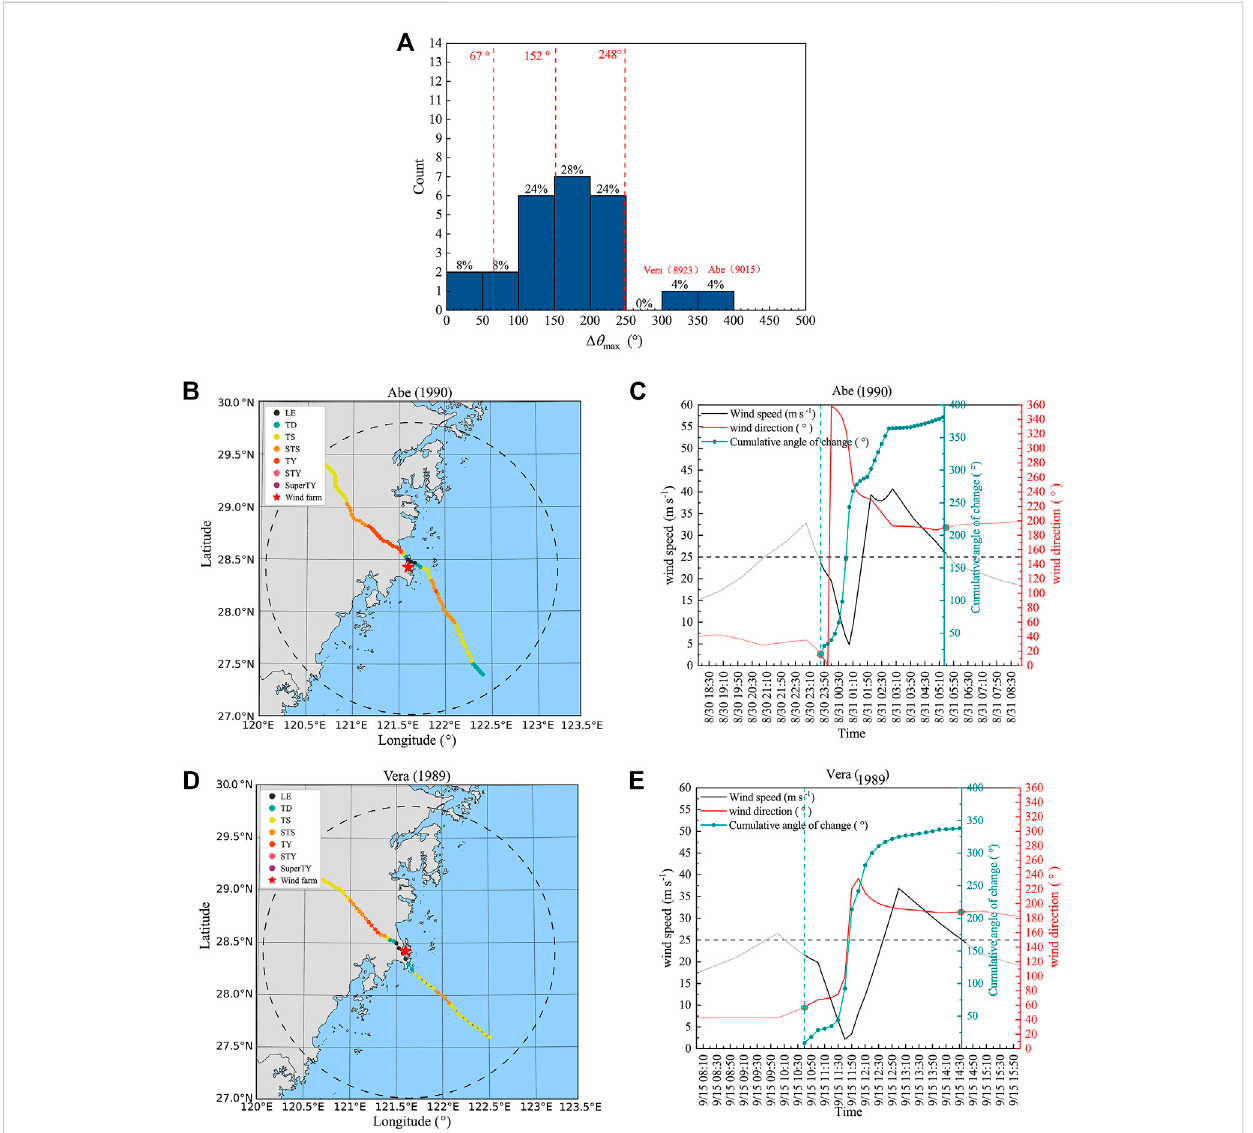
FIGURE 9 (A) Frequency distribution of the maximum cumulative wind direction change at hub height under the in fl uence of tropical cyclones ( Δ θ D) the best-track positions and intensities, and (C and E) temporal variations of wind speed and wind direction for tropical cyclones (B,C) Abe (1990) and (D,E) Vera (1989). Orange dashed lines in (A) are the threshold cutoffs of 67 ° , 152 ° , and 248 ° , black dashed circle represents the study area with radius of 150 km centered on the wind farm, green dashed line and green curve in (C and E) denote the start time of Δ θ max and the cumulative change angle curve,